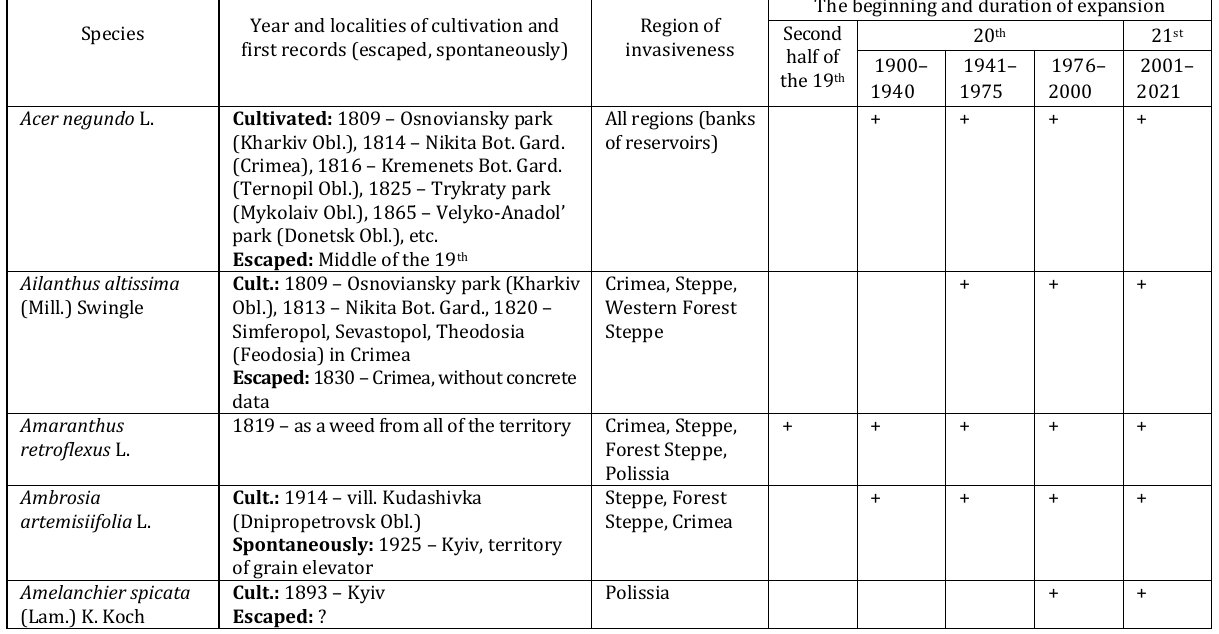
Table 1. Expansion of alien plant species in Ukraine in the 19th–21st centuries Region of Species Year and localities of cultivation and first records (escaped, spontaneously)